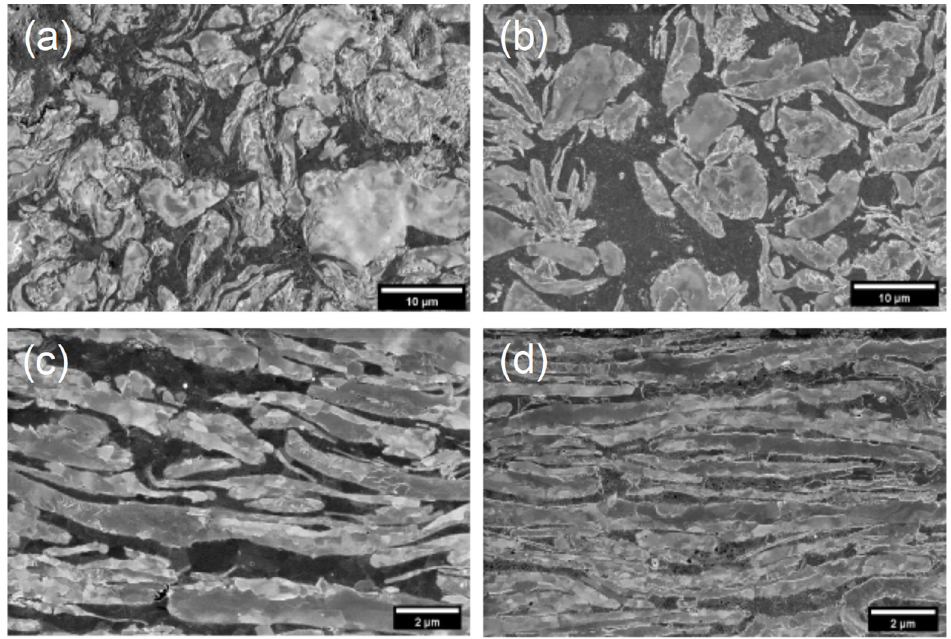
Figure 4. SEM micrographs for polished sections of ( a , c ) Cu-W and ( b , d ) Cu-W-0.1 wt.% GO sin- tered at 1000 °C viewed parallel ( a , b ) and perpendicular ( c , d ) to the extrusion